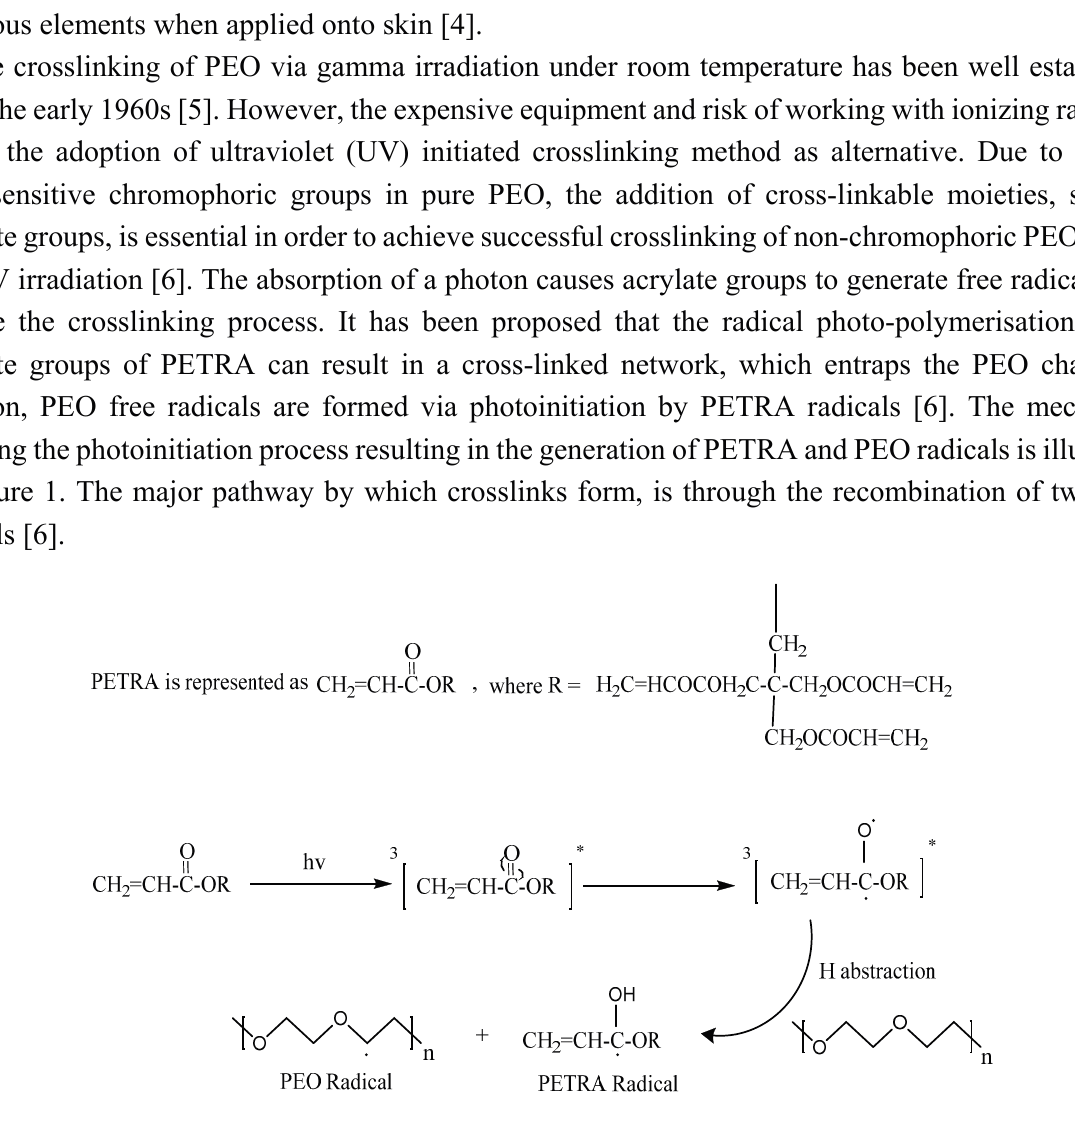
Figure 1. Generation of reactive PEO free radicals with the aid of PETRA as photoinitiator, figure adapted from Doytcheva et al.